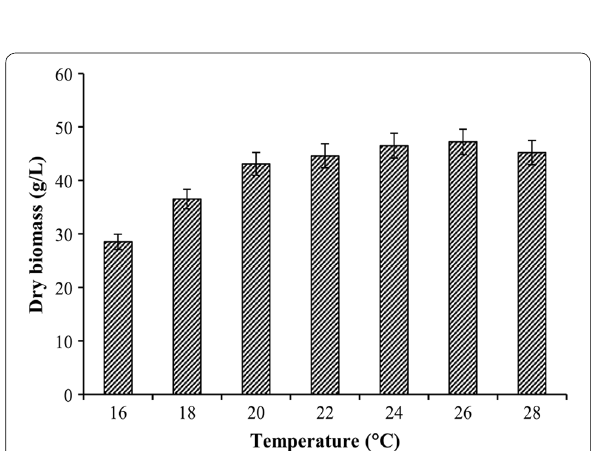
Fig. 3 Effect of different culture temperature on dry biomass by B. trispora . Error bars indicate SEs of mean values